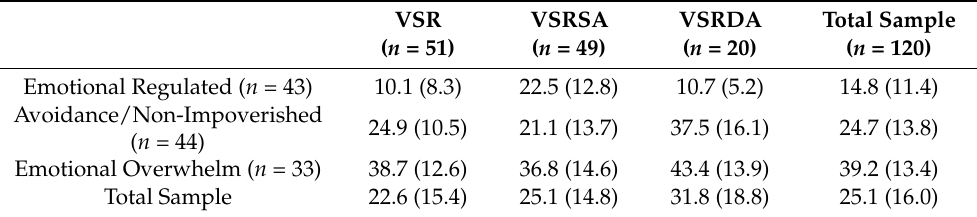
Means are displayed along with standard deviations (SD). VSR: victims with a single report, VSRSA: victims with several reports by the same aggressor, VSRDA: victims with several reports by different